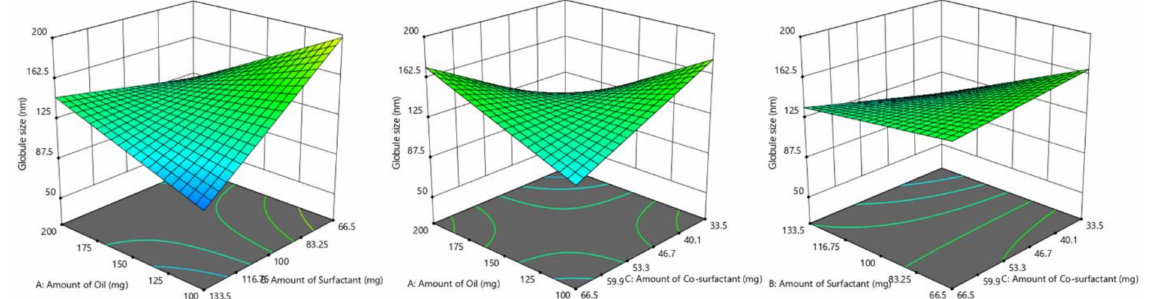
Figure 5. 3D surface plot showing the effect of formulation factors: glycerol triacetate (oil); Tween 80 (surfactant); and PEG 200 (co-surfactant)] on globule size (Y 2 ). The values X 1 X 2 , X 1 X 3 , X 2 X 3 demonstrate beneficial or synergistic interactions between oil–surfactant, surfactant–co-surfactant, and oil–co-surfactant to droplet size. It disclosed that the average globule size of the emulsion reduced with increased surfactant concentra- tion due to the creation of a larger oil-water interface [53].